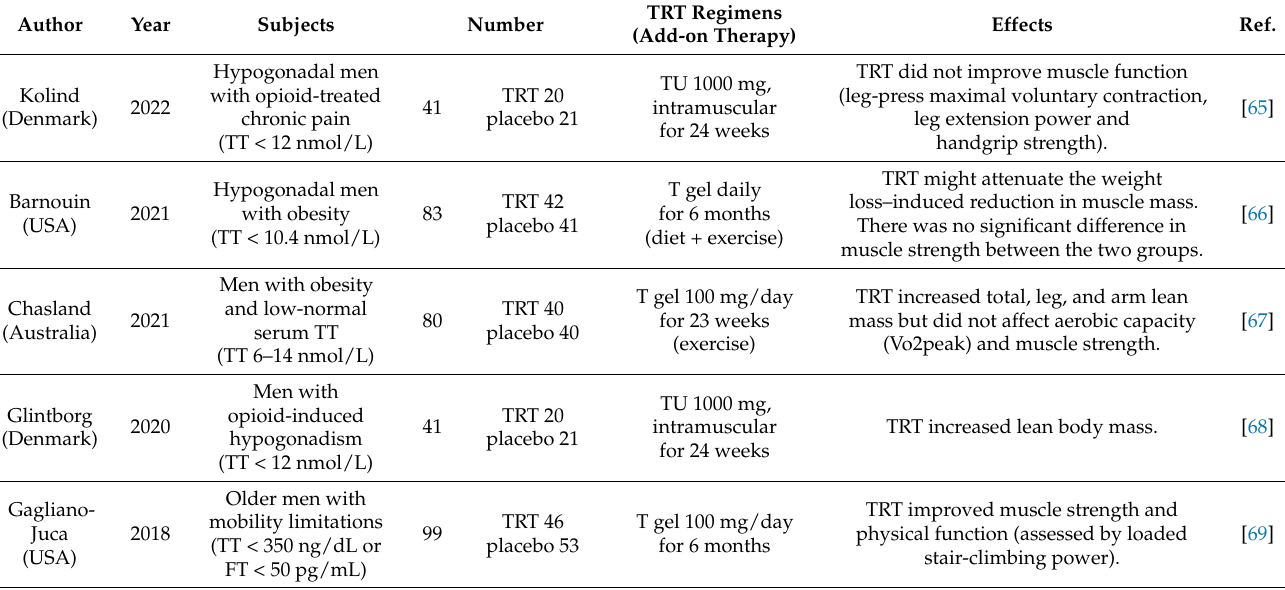
Table 2. Randomized control trials to investigate the effects of testosterone replacement therapy (TRT) on muscle (published since